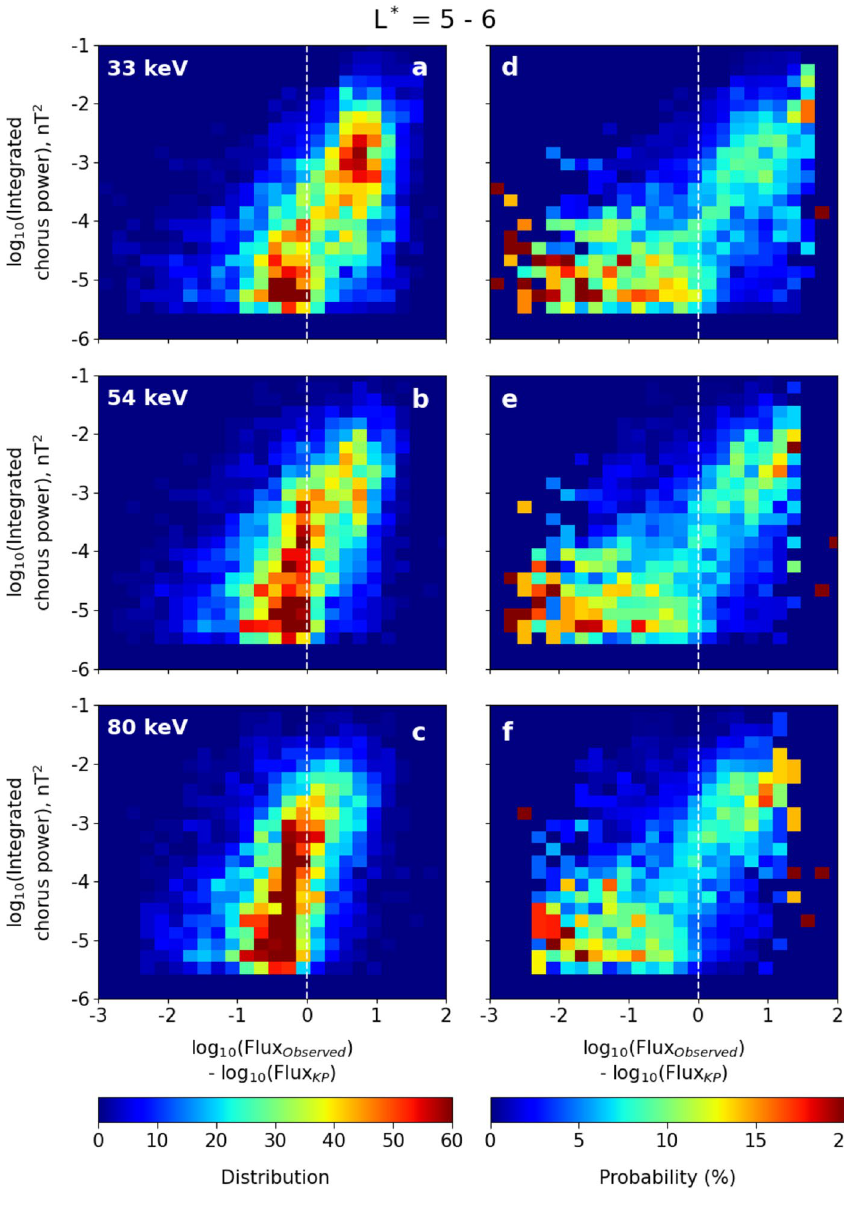
Figure 5. Same as in Fig. 4, but in the L* range 5 − 6